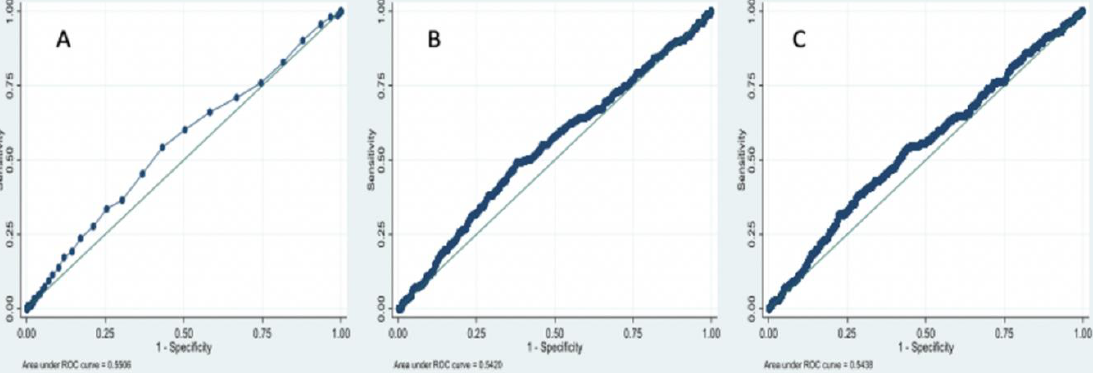
Figure 2. ROC curve of ( A ) NLR; ( B ) PLR and ( C ) SII.